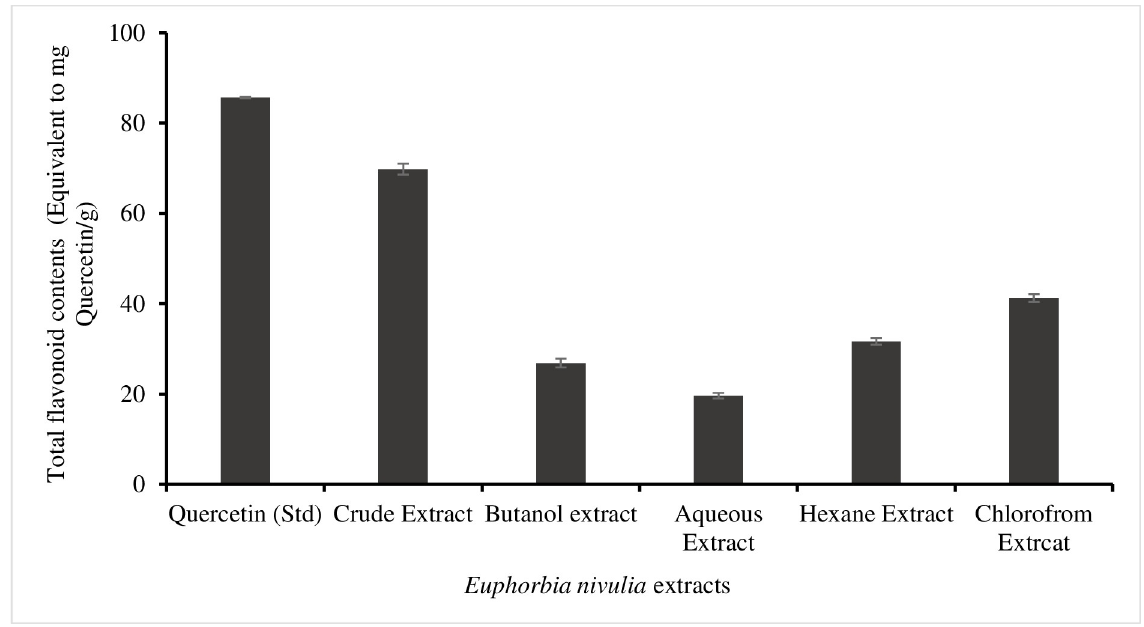
Fig 1. Total flavonoid contents in Euphorbia nivulia Buch.-Ham. crude extract and various fractions.